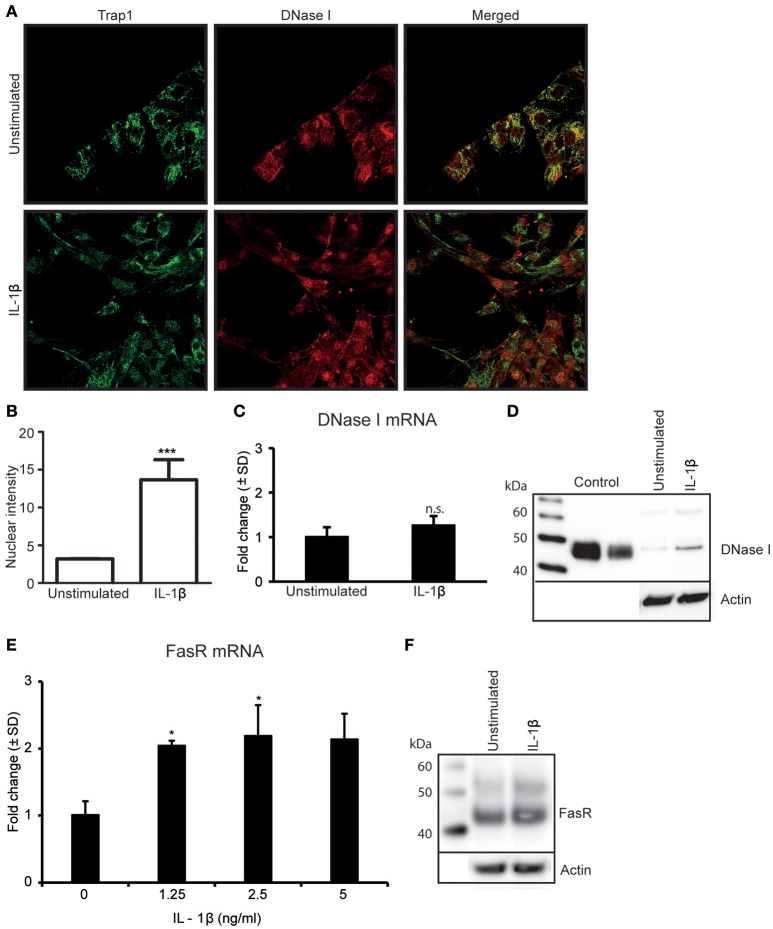
Stimulation of RPTEC with IL-1β promotes nuclear translocation of DNase I and upregulatesFasR expression levels. Stimulation of RPTEC with 2.5 ng/ml of IL-1β for 48 h did not upregulate DNase I protein expression but imposed nuclear translocation of DNase I as demonstrated by confocal microscopy (DNase I: red, Trap 1: green) (A). Intensity of nuclear DNase I staining was measured using ImageJ (B). Stimulation of RPTEC with 2.5 ng of IL-1β for 48 h did not affect DNase I mRNA (C) and protein expression levels (D). Importantly, enhanced FasR mRNA (E) and protein levels (F) were observed in cells after IL-1β stimulation. In this experiment, a nearby full FasR mRNA response was achieved when stimulating the RPTEC cultures with 1.25 ng/ml of IL-1β (E). Significances: *P ≤ 0.05; ***P ≤ 0.0005.